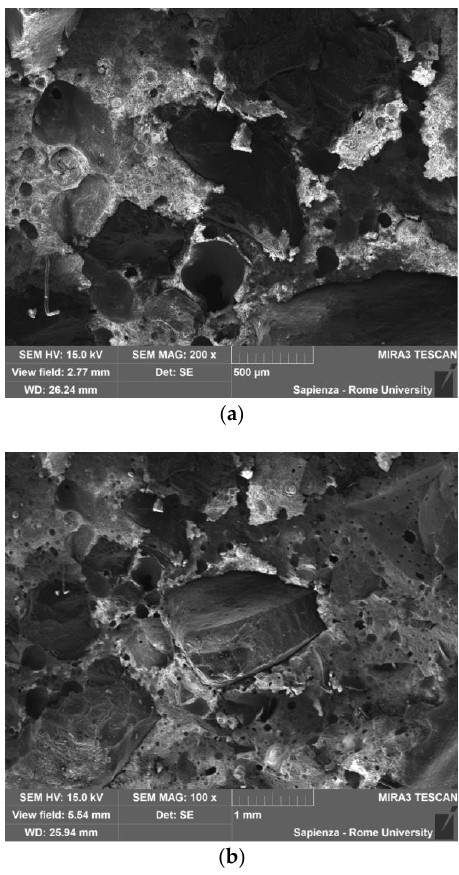
Figure 10. FEG-SEM micrographs on GTR–cement interface adhesion: rubber powder ( a ) and rubber granule ( b ).